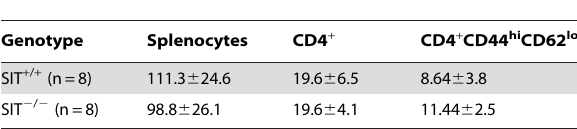
Table 2. T-cell subpopulations in the spleen.